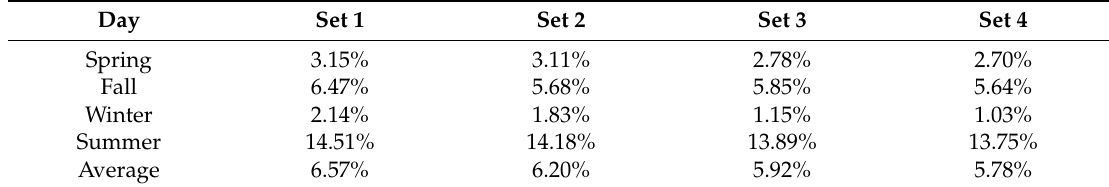
Table 8. Input Data Dependency Results—Stage 2.